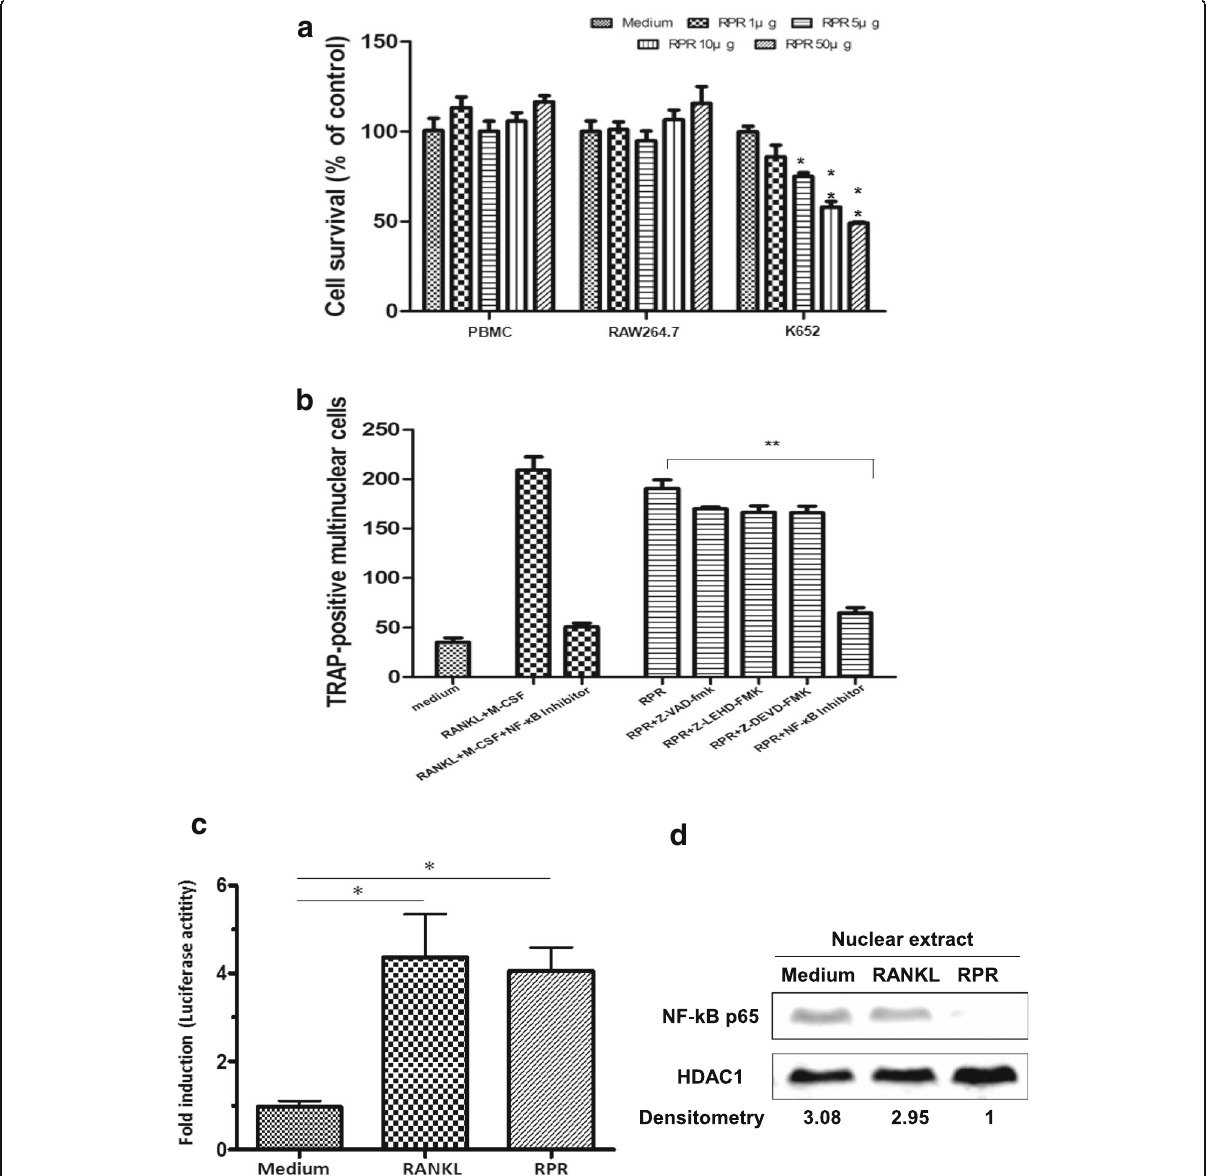
Fig. 3 Dependence of RPR-induced osteoclast differentiation on NF- κ B stimulation. a Human monocytes, RAW264.7 macrophages, and K562 cells were developed with RPR proteins for 18 h. The MTT assay examined cell survival. Data are the mean ± SD of at least three separate tests;* p < 0.01; ** p < 0.001, compared with the control for the agent alone. b RAW 264.7 cells were given RPR (10 μ g/ml) or RANKL and M-CSF, with or without the NF- κ B inhibitor (NF- κ B SN50), pan-caspase inhibitor (Z-VAD-fmk), caspase-9 specific inhibitor (Z-LEHD-FMK), or caspase-3 specific inhibitor (Z-DEVD-FMK). After incubation for 7 days, a TRAP assay was utilized on the cells. Data are the mean ± SD of at least three independent experiments; ** p < 0.001. c Murine RAW264.7 macrophages were transfected with an NF- κ B luciferase reporter. After 24 h of transfection, cells were treated with RPR (100 ng/ml) or RANKL (100 ng/ml) for 14 h, then lysed for the luciferase assay. A dual-luciferase reporter assay system determined luciferase activity. Data are the mean ± SD of at least three samples. The results reflected at least three independent tests of the same experiment; * p < 0.01. d The effects of RPR (100 ng/ml) or RANKL (100 ng/ml) on nuclear NF- κ B-p65 levels in murine RAW264.7 macrophages after 30 mins of treatment. RANKL activated NF- κ B in RAW264.7. The agent alone did not affect NF- κ B stimulation. Each band ’ s β -actin value normalized the densitometry